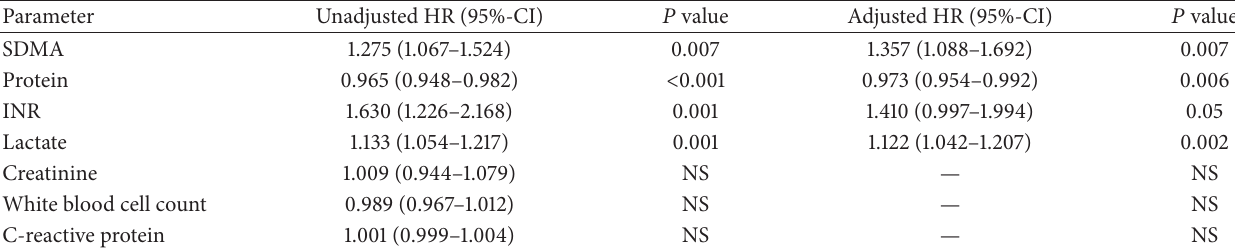
Table 5: Uni- and multivariate Cox regression analyses for SDMA levels at admission to predict overall